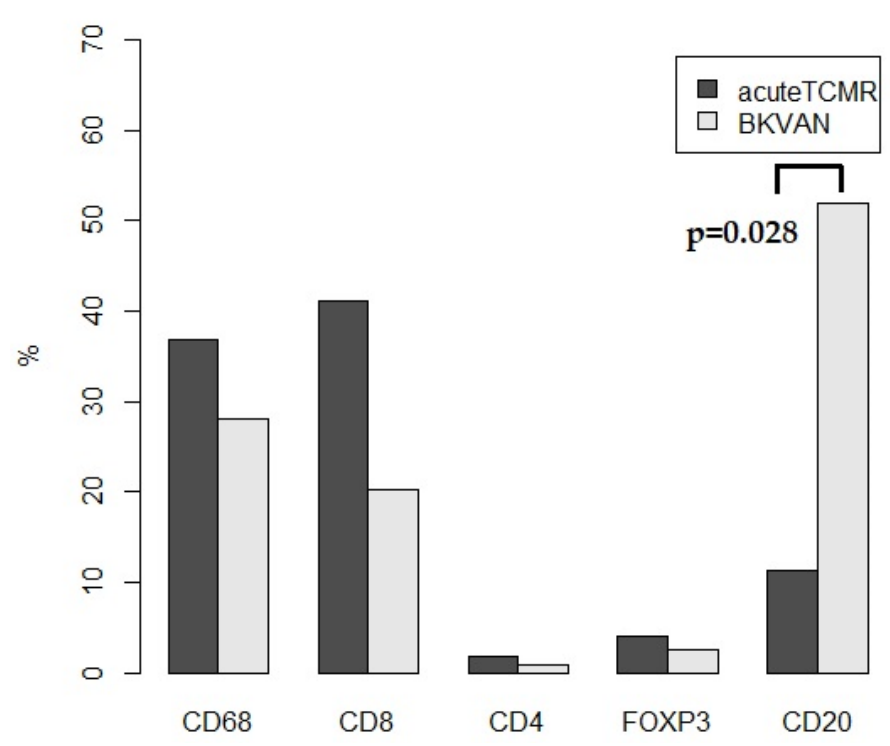
Figure 5. The proportions of mononuclear cell subsets for acute TCMR versus BKVAN cases in medullary ray.